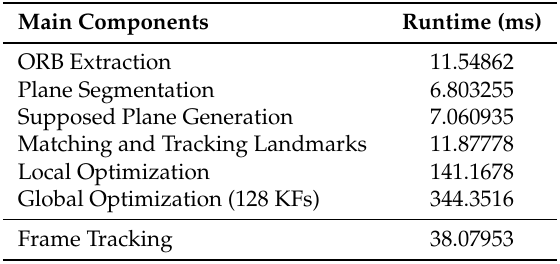
Table 5. Average runtime (unit: ms) of different